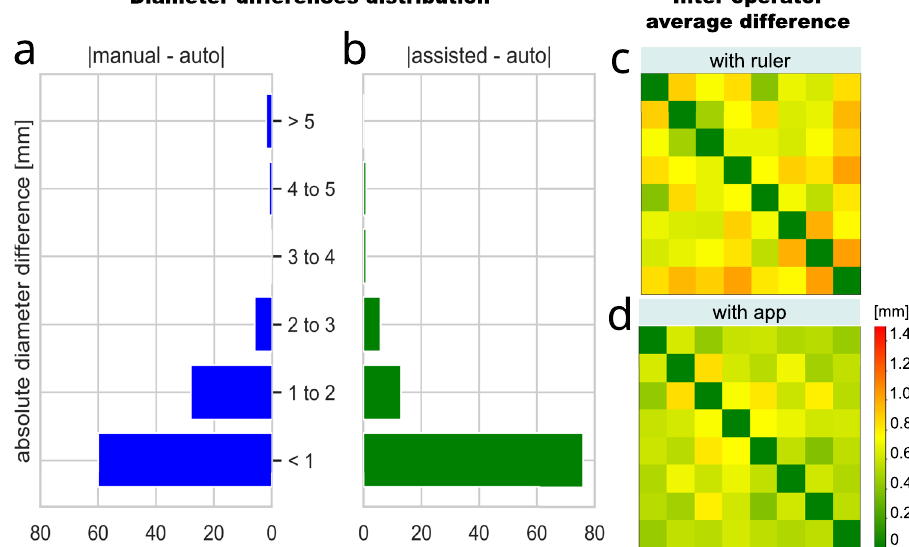
Fig. 4 Benchmark results on dataset A3. The histograms ( a , b ) show the distribution of the absolute diameter differences between the App ’ s automatic procedure (auto) and the manual measurement with ruler ( a ) as well as with the diameter adjusted on the smartphone by the technicians (assisted, b ). On the right, the heat-maps show the average absolute measurement difference among the eight technicians (given two readers i and j , square i , j represents the average difference between them) measuring with the ruler ( c ) and in assisted mode with the App ( d ). The assisted measure seems to reduce inter- operator